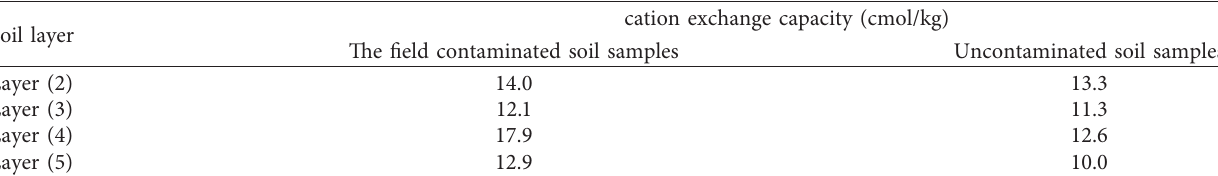
Table 2: The cation exchange capacity of uncontaminated saturated clay and contaminated with TCE saturated clay. Soil